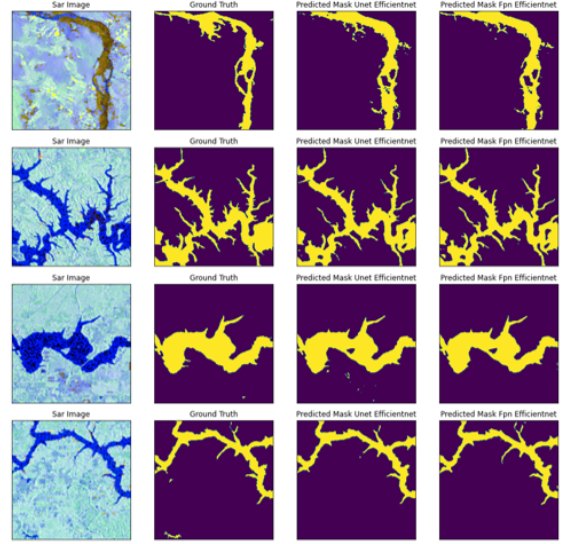
Figure 6. Figure showing the SAR composite image, the corresponding ground truth and the prediction results for both the UNet and the FPN models for the training and validation dataset from Bangladesh, Nebraska and North Alabama flood